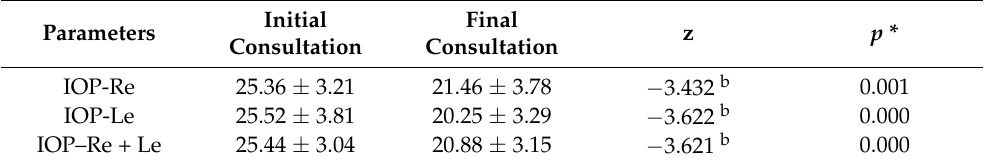
Table 3. Distribution of IOP parameters in OHT suspects patients, at the first and last consultation. Parameters